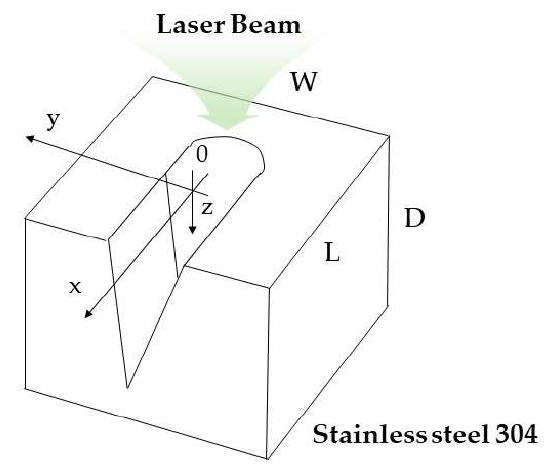
Figure 2. Schematic diagram for the physical model of stainless-steel 304 workpiece for optical analysis.